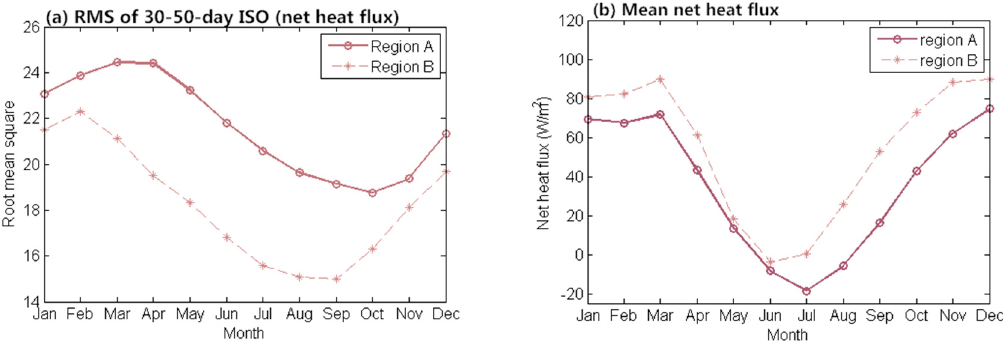
Figure 8. ( a ) RMS variance; and ( b ) mean net heat flux averaged in Regions A and B as a function of calendar month during 1984-2009.